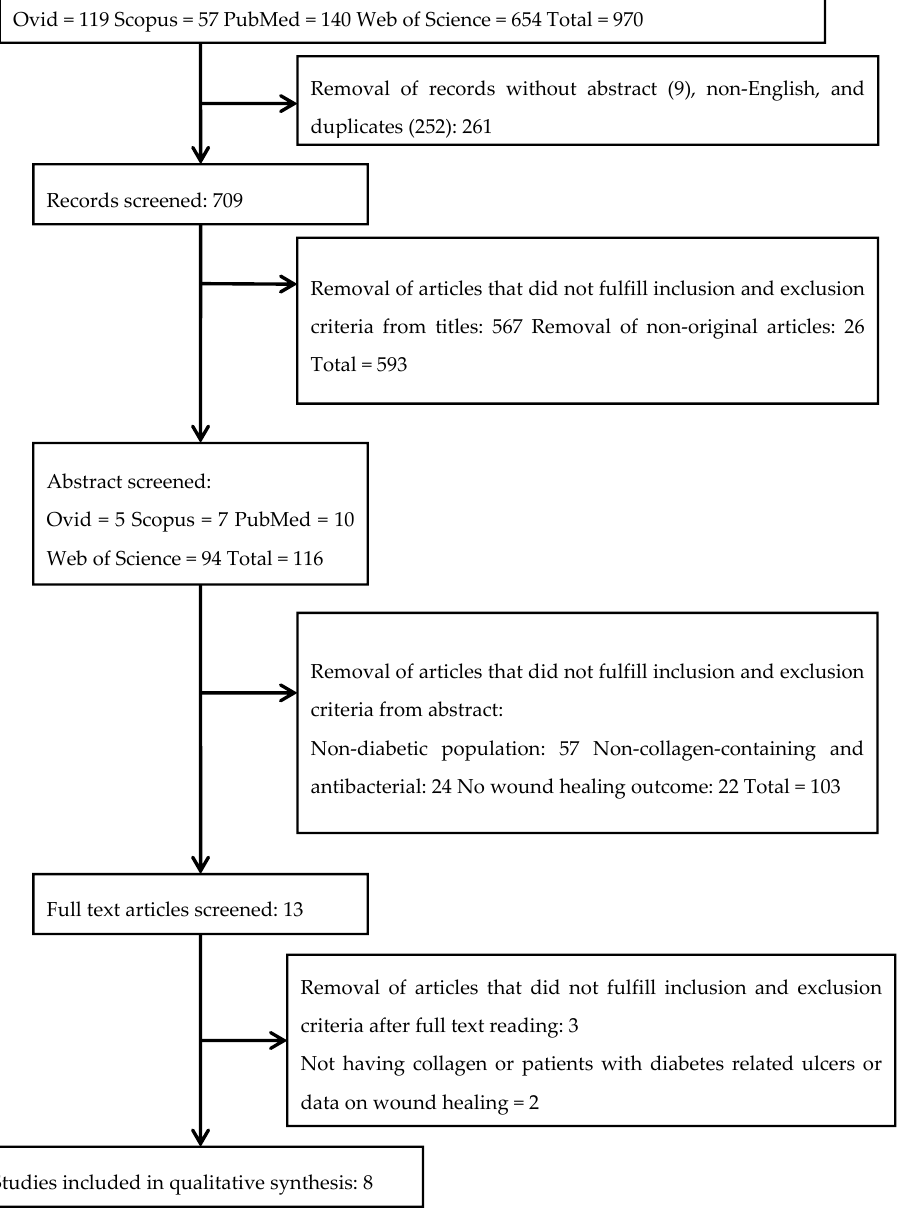
Figure 1. Flow chart of the screening process.